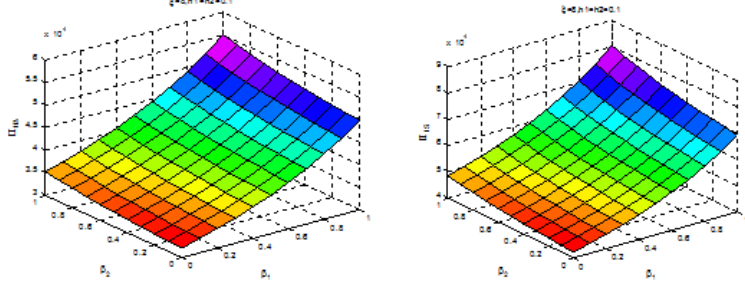
Figure 3. The change of the optimal profits with the return price in two